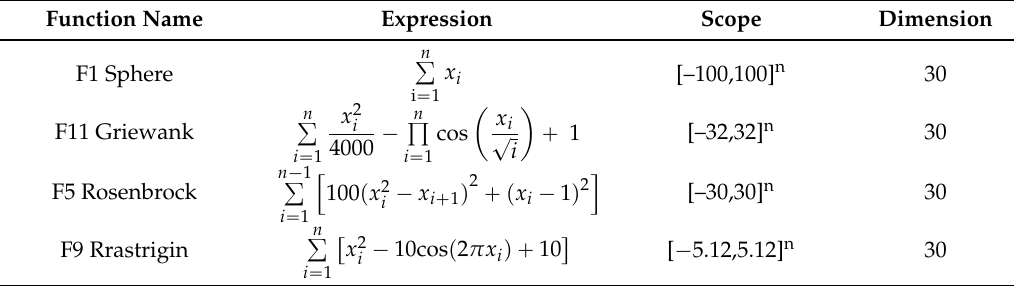
Table 1. Testing functions.